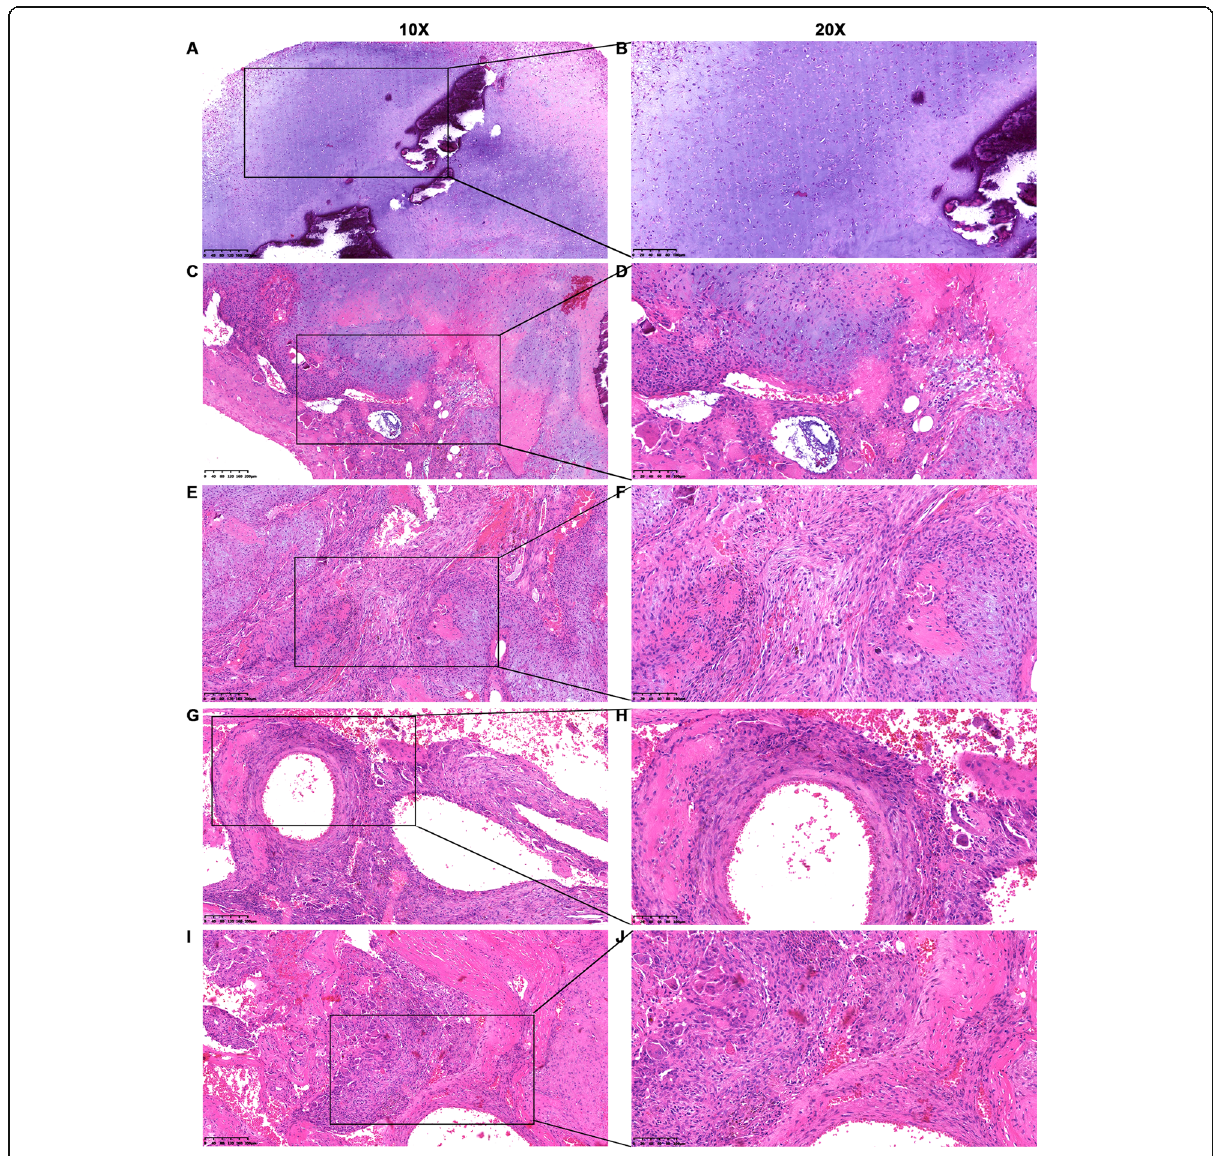
Fig. 3 Pathological characteristics of the chondromesenchymal hamartoma (HE staining) in case 1. a , b Hyaline cartilage with endochondral calcification. c , d Hyaline cartilage with endochondral ossification and calcification surrounds the ABC-like area. In the lower left region, the fibrous wall is composed of connective tissue stroma with scattered osteoid trabeculae and osteoclast-like giant cells. e , f A number of mesenchymal spindle-shaped cells interwoven with multilobulated hyaline cartilage. g , h Typical secondary ABC structures appearing as cystic spaces containing red blood cells. The fibrous walls are composed of connective tissue stroma with scattered osteoid trabeculae and osteoclast-like giant cells. Ossification frequently appears within the fibrous walls and among the cartilage background. i , j Disorganized mixture of mesenchymal spindle cells, multinucleated osteoclastic giant cells, endochondral ossification, and hemorrhagic spaces with fibrous cystic walls. Left panel, ×10; right panel, ×20. HE, hematoxylin and eosin; ABC, aneurysmal bone